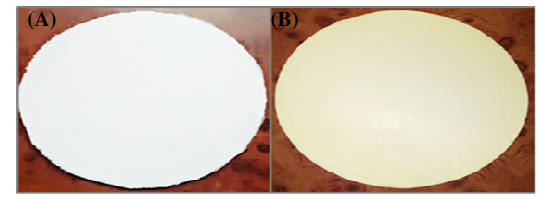
Fig. 3. Photographs of (Nylon 6) nanofibrous web (A) Without (AgNO ) and (B) Nylon 6 with (AgNO 3